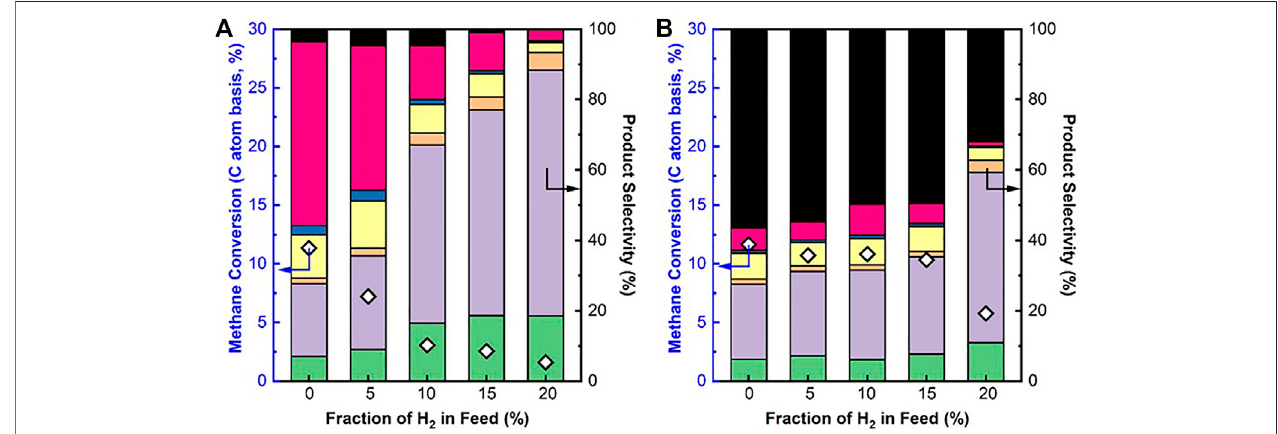
FIGURE 5 | CH 4 conversion and product selectivity in DNMC over Fe/SiO 2 catalyst (A) and SCZO perovskite oxide (B) in a fi xed-bed reactor at different hydrogen co-feed concentrations (1273 K temperature, 101.325 kPa pressure, 3,200 mlg − 1 h − 1 space velocity, molar ratio of N 2 /CH 4 (cid:1) 1/9, N 2 used as internal standard, ToS of 1 h) (symbol indicators: coke, naphthalene, toluene, benzene, ethane, ethylene, and acetylene.